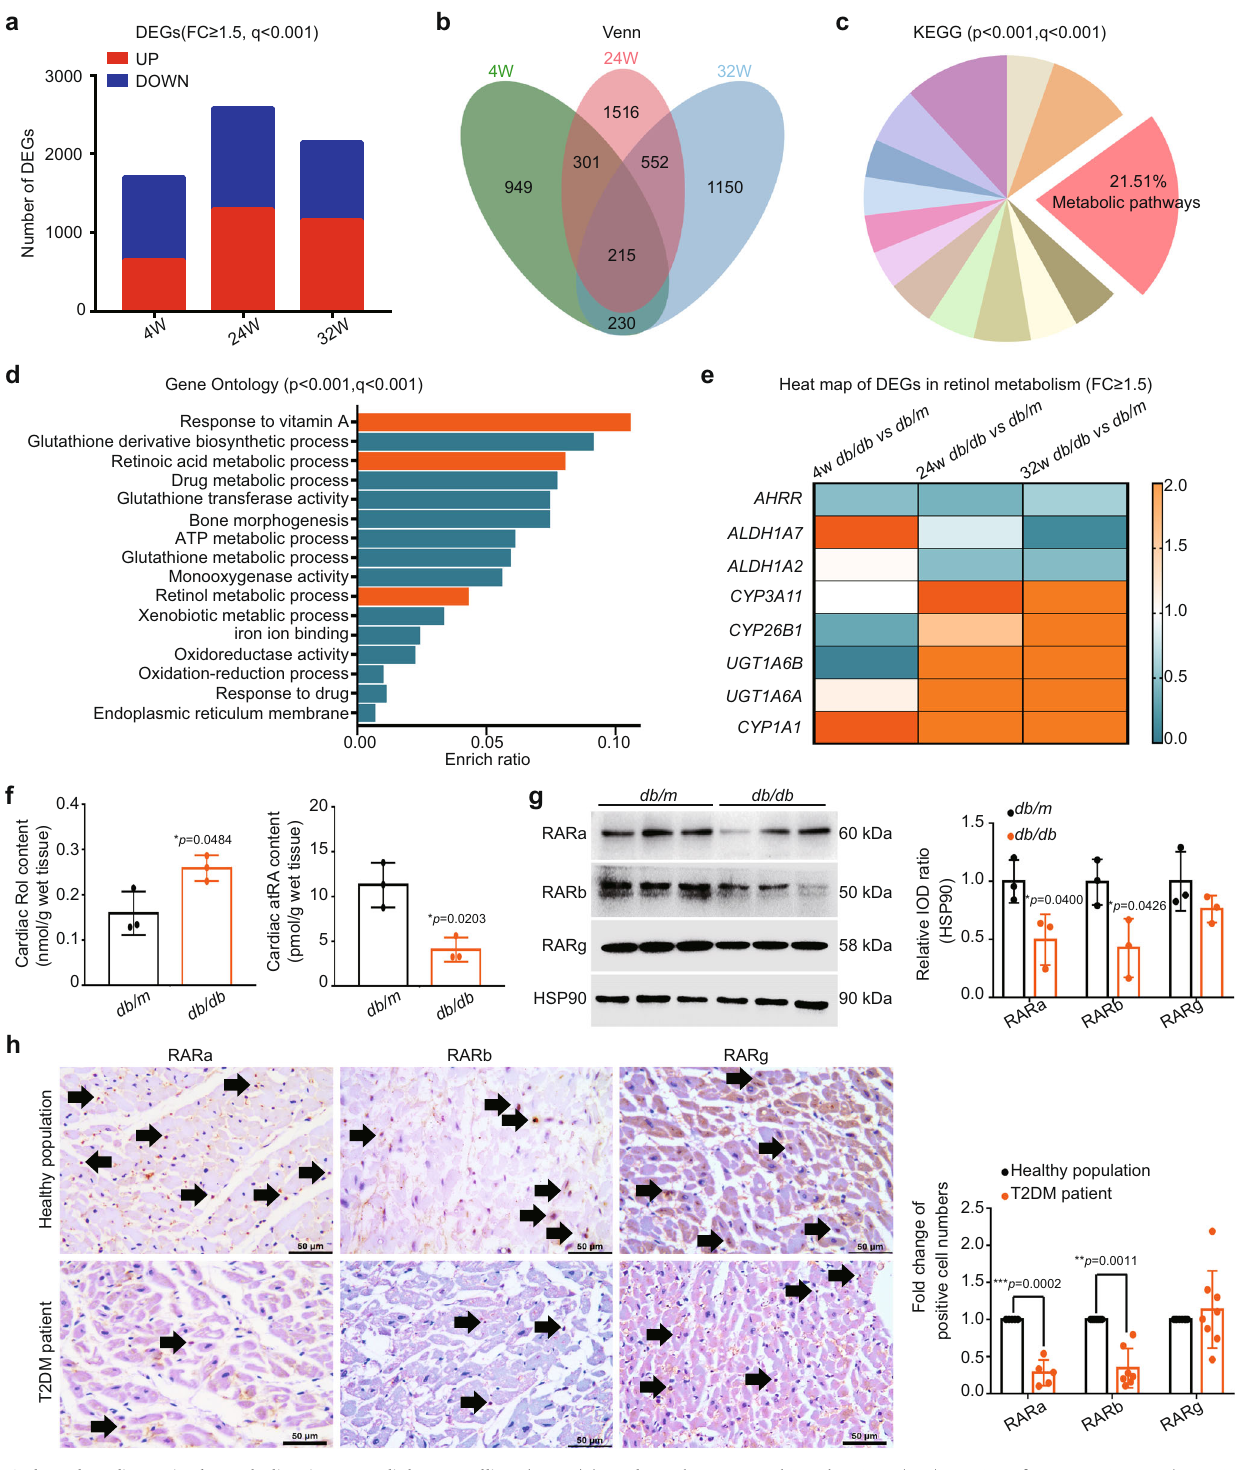
Fig.1|Alteredcardiacretinolmetabolismintype2diabetesmellitus(T2DM)(n meansbiologicallyindependentanimals).a Summaryofdifferentiallyexpressed genes (DEGs). b Venn diagram of DEGs. c Kyoto Encyclopedia of Genes and Gen- omes (KEGG) analysis of DEGs. d Gene ontology (GO) terms analysis of DEGs in metabolic pathways. e Heat map of DEGs in retinol metabolism pathway. f Cardiac retinol (Rol) and all-trans retinoic acid (atRA) levels in db/db mice, n =3, * vs db/m . g Western blotting (WB) of cardiac (retinoic acid receptors) RARs, n =3, * vs db/m .